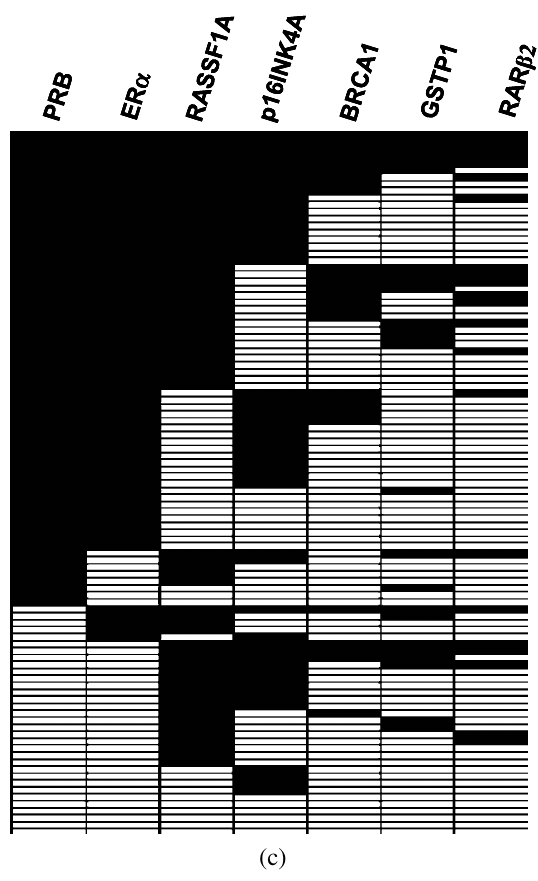
Each row is a primary breast tumor. Methylated genes are repre- sented as dark rectangles and unmethylated genes are displayed